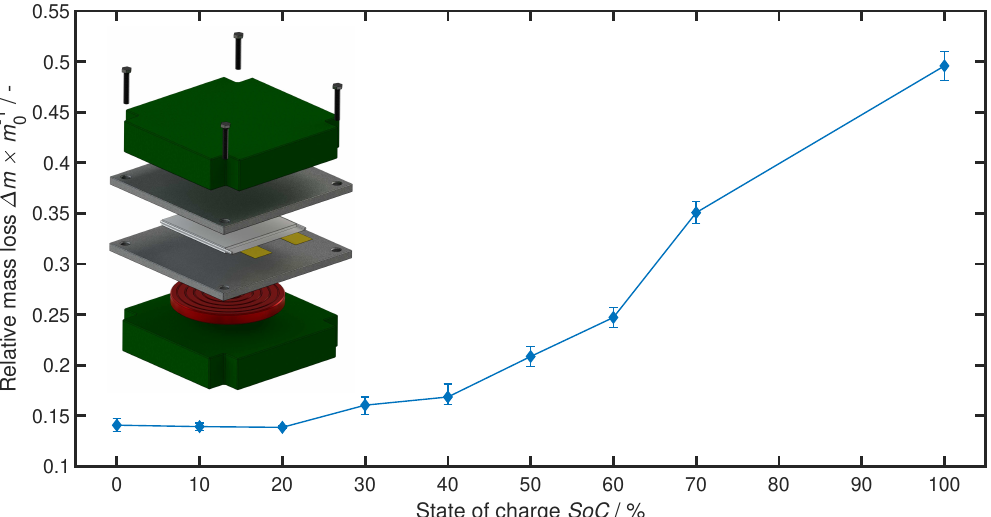
Figure 2. Impact of SoC on relative cell mass loss ∆ m during thermal runaway (TR) scaled to cell mass m 0 before TR. Small picture: Schematic of the test set-up. A lithium-ion cell is placed between two aluminium jigs and heated via a hot plate. Insulation pads on the very top and bottom prevent excessive heat